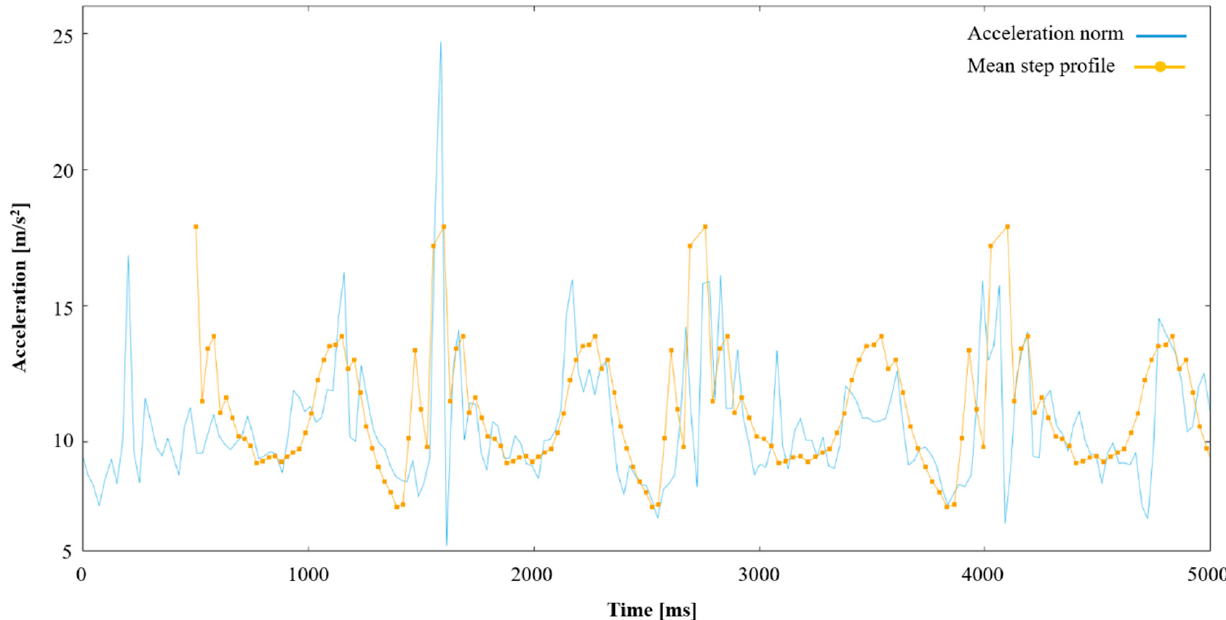
Figure 3. Acceleration norm during impeded gait (walking a part of the obstacle course) presented together with an overlay of the calculated mean step profile during unobstructed walk.